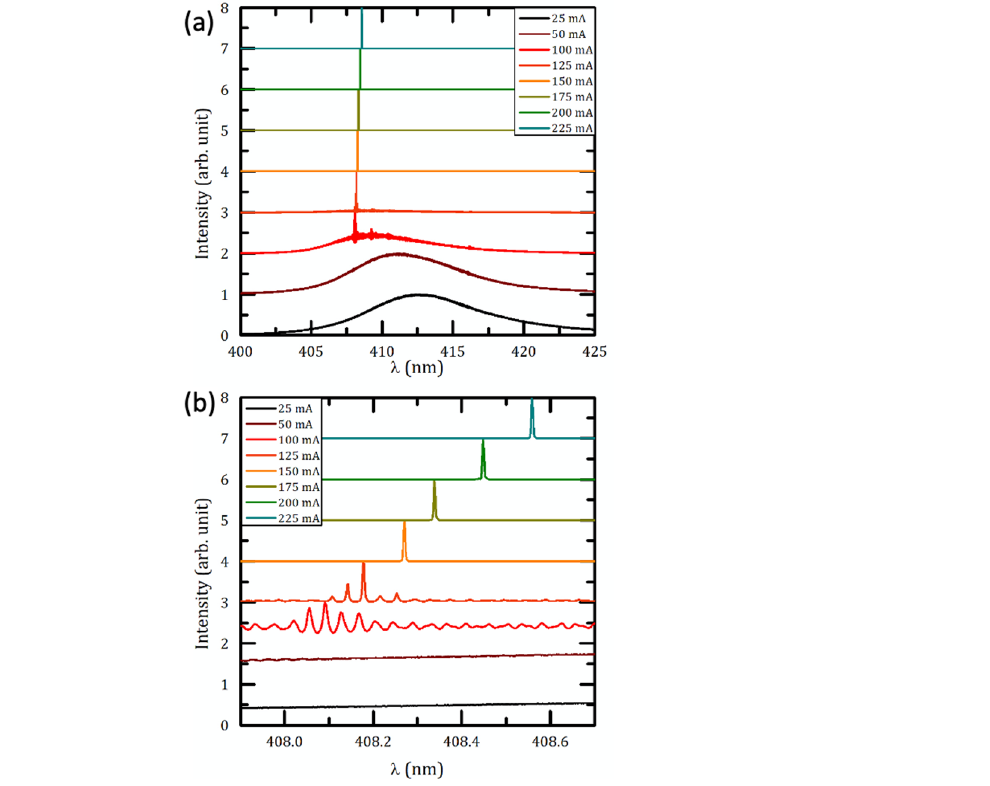
Figure 10. ( a ) Emission spectra for a 39th-order DFB GaN LD at different driving currents shown over a large wavelength range and ( b ) a small wavelength range.